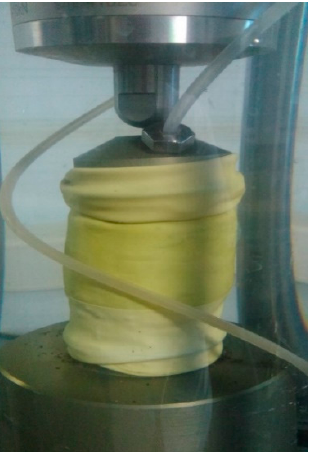
Figure A7. Sample of molding sand after tests in triaxial compression apparatus.